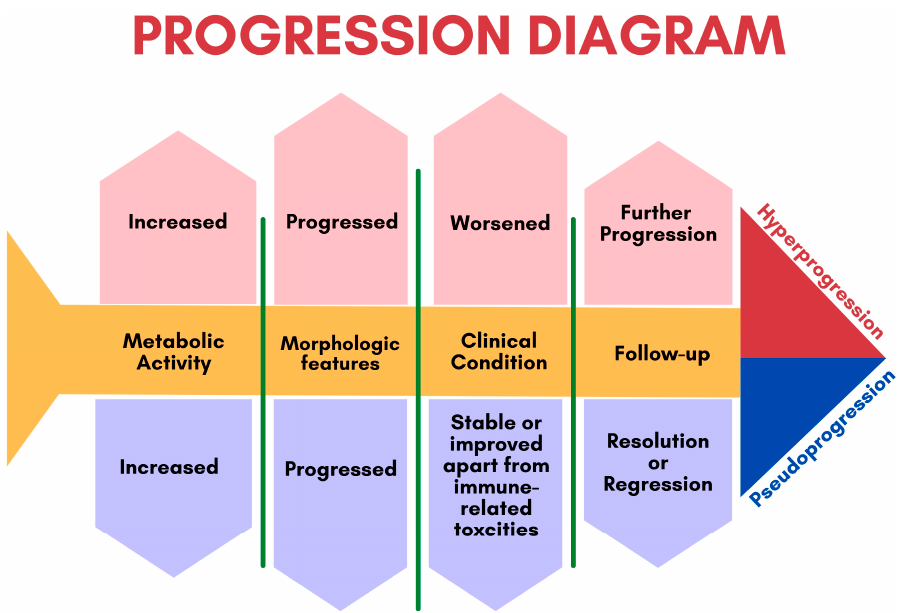
Figure 4. A fish bone diagram demonstrating the difference between pseudoprogression and hyperprogression.